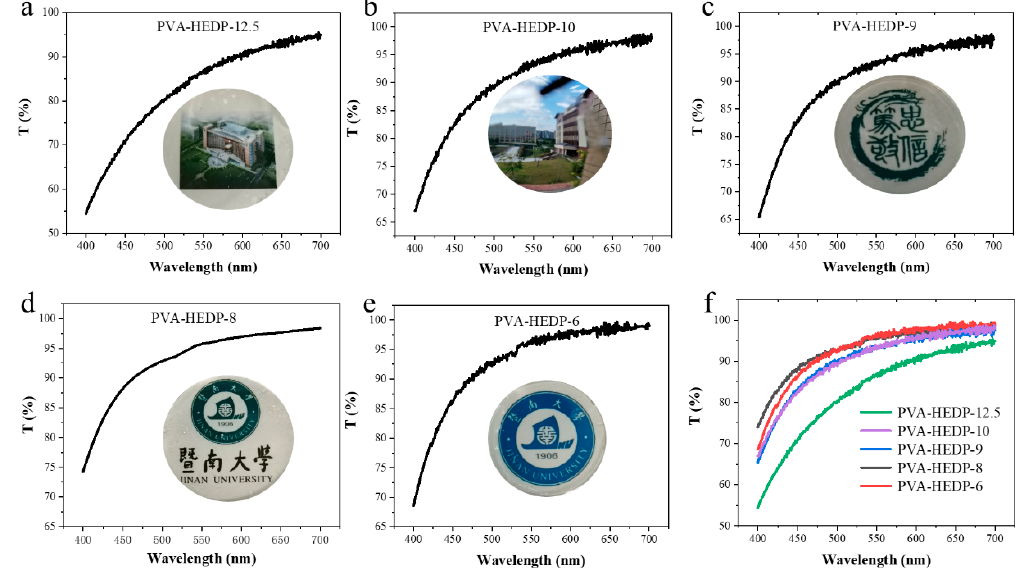
Figure 3. UV − vis spectra and graphs of PVA-HEDP hydrogels with different HEDP content. ( a ) PVA-HEDP-12.5, ( b ) PVA- HEDP-10, ( c ) PVA-HEDP-9, ( d ) PVA-HEDP-8, ( e ) PVA-HEDP-6, ( f ) transparency of the hydrogels with different HEDP content.